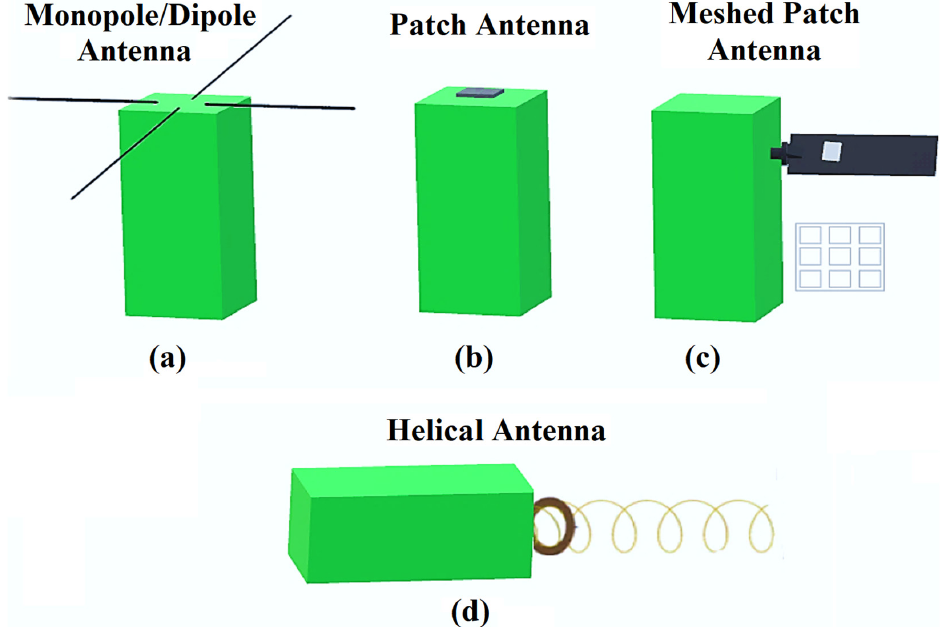
Figure 7. Popular antenna designs proposed in the literature. ( a ) Monopole/Dipole; ( b ) Patch; ( c ) Meshed Patch and ( d ) Helical Patch.